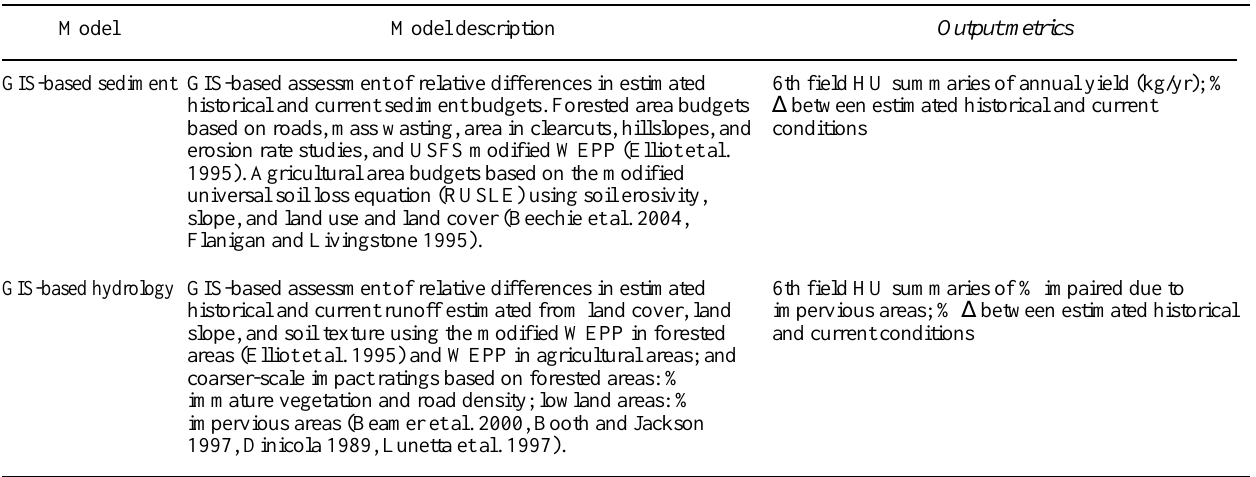
Table 4. GIS-based models to evaluate the current landscape and to generate the landscape-watershed management strategy. change ( D